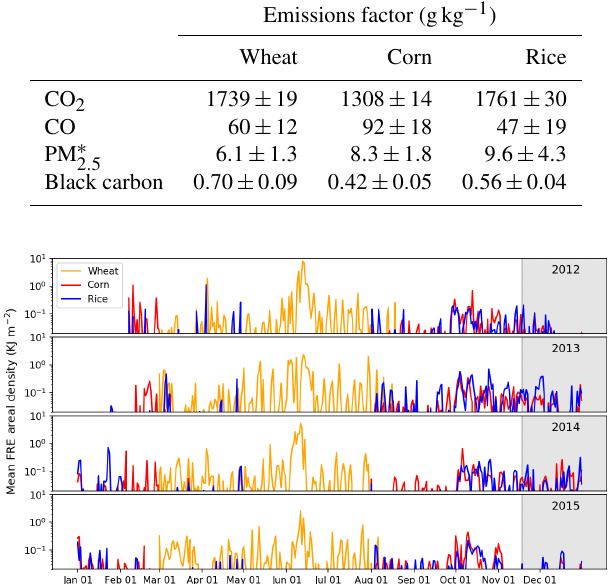
Figure 5. Time series of mean daily FRE areal density (kJm − 2 ; calculated per 0.1 ◦ grid cell) from 2012 to 2015 for the entire study area disaggregated by crop residue type (wheat, corn, and rice) ac- cording to the method described in Sect. 2.3. Grey shaded areas highlight the newly discovered winter burning season from mid- November to December when no crop harvesting occurs but where fires are clearly occurring. This period of agricultural burning is dis- cussed further in Sect.